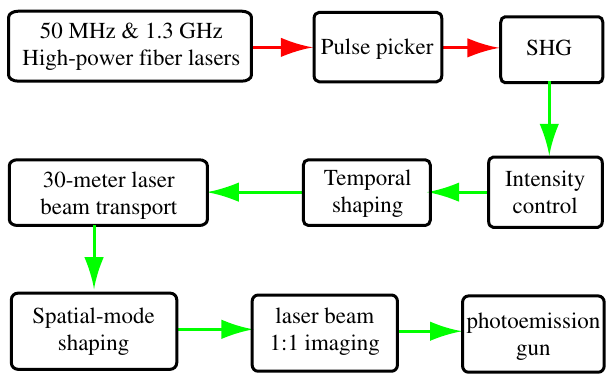
FIG. 1. Overview of the laser system for Cornell ERL